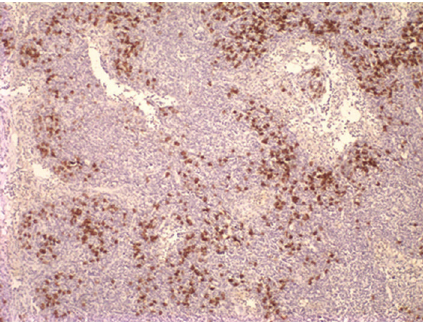
Figure 1: A pale staining, irregular area consists of minimal necrosis surrounded by a wide zone of immunoblasts and histiocytes (H&E, × 10).